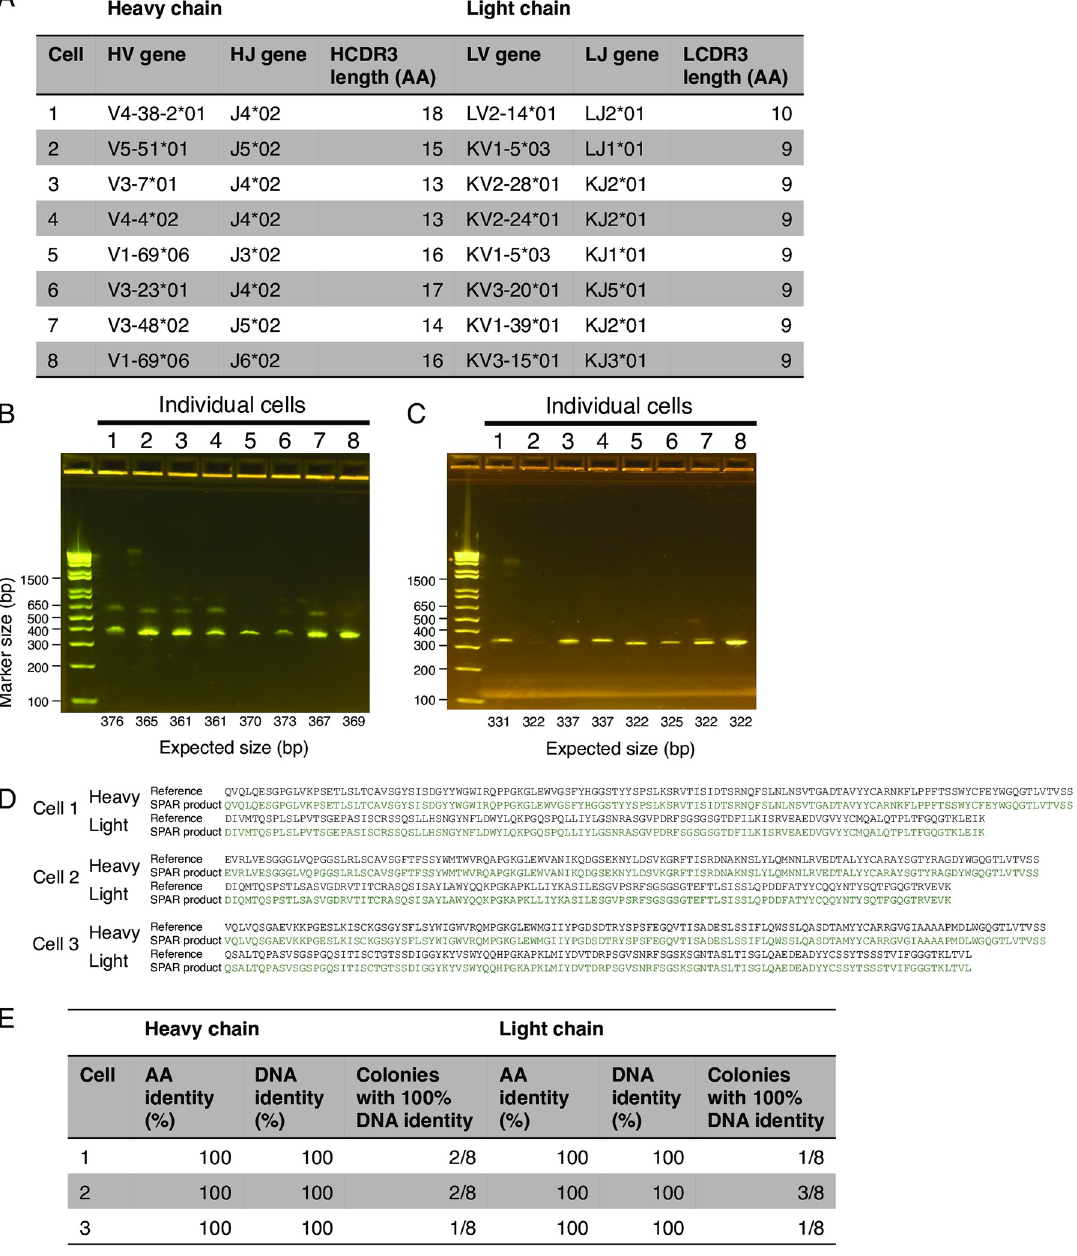
PLOS ONE | https://doi.org/10.1371/journal.pone.0236477 August 5,